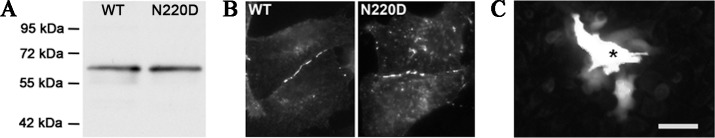
Cx50N220D production, localization and function in transfected cells.(A) Proteins from homogenates of HeLa cells transiently transfected with wild type Cx50 or Cx50N220D were resolved by SDS-PAGE and subjected to immunoblotting using rabbit polyclonal anti-human Cx50 antibodies. Samples from cells expressing either Cx50 or Cx50N220D contain a single immunoreactive band of similar mobility. Molecular mass standards are indicated on the left. (B) Photomicrographs show the distribution of immunoreactivity to anti-Cx50 antibodies in HeLa cells transfected with wild type Cx50 (WT) or Cx50N220D (N220D). Cells expressing WT and N220D both show substantial labeling at appositional interfaces between cells consistent with gap junction plaques. (C) Photomicrograph showing intercellular neurobiotin transfer from a microinjected cell (*) to neighboring cells in HeLa cells transiently with CX50N220D. Bar, 16 μm for B and 10 μm for C.